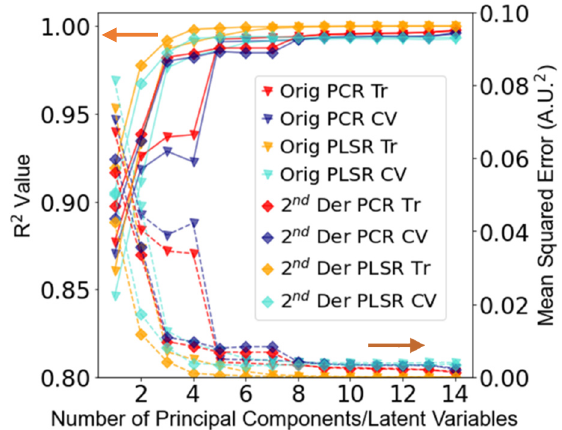
Figure 3. R 2 and MSE values for PCR and PLSR models using the training (Tr) and cross-validation Figure 3. 𝑅 (cid:2870) and 𝑀𝑆𝐸 values for PCR and PLSR models using the training (Tr) and cross-validation (CV) data from the calibration dataset. Solid lines pertain to 𝑅 (cid:2870) , and dotted lines pertain to 𝑀𝑆𝐸 . (CV) data from the calibration dataset. Solid lines pertain to R 2 , and dotted lines pertain to MSE .